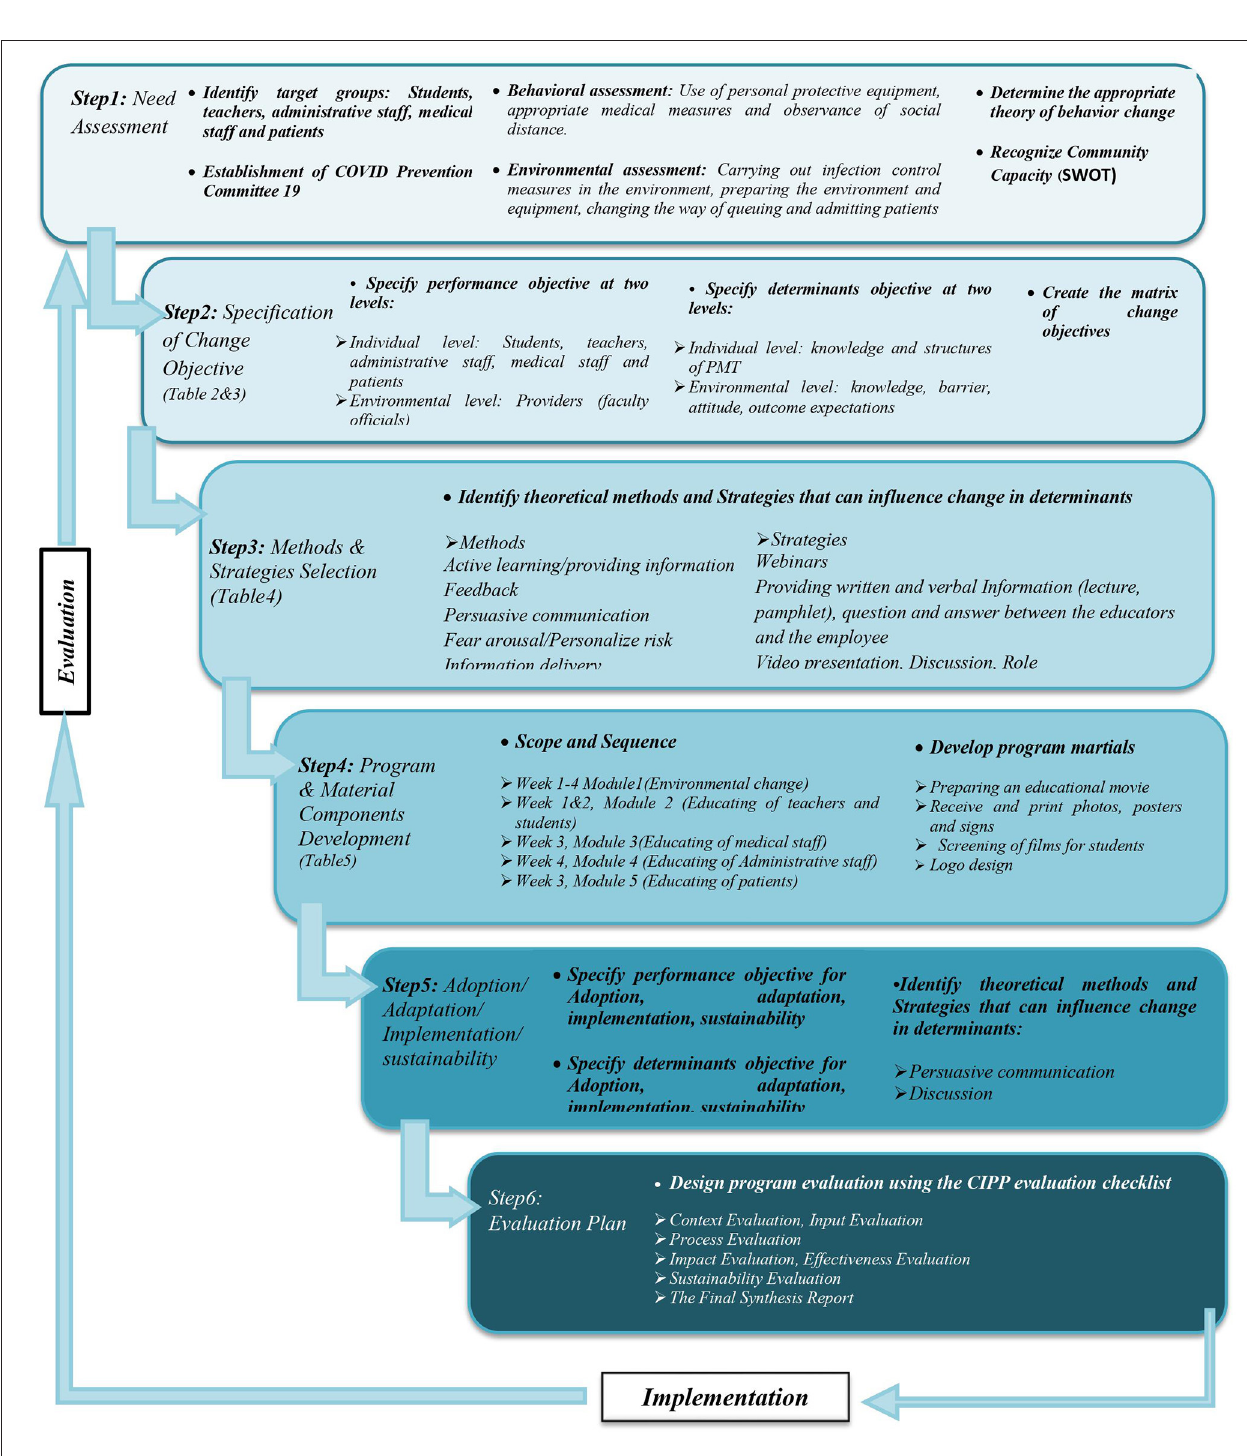
FIGURE 2 | Implementation intervention mapping